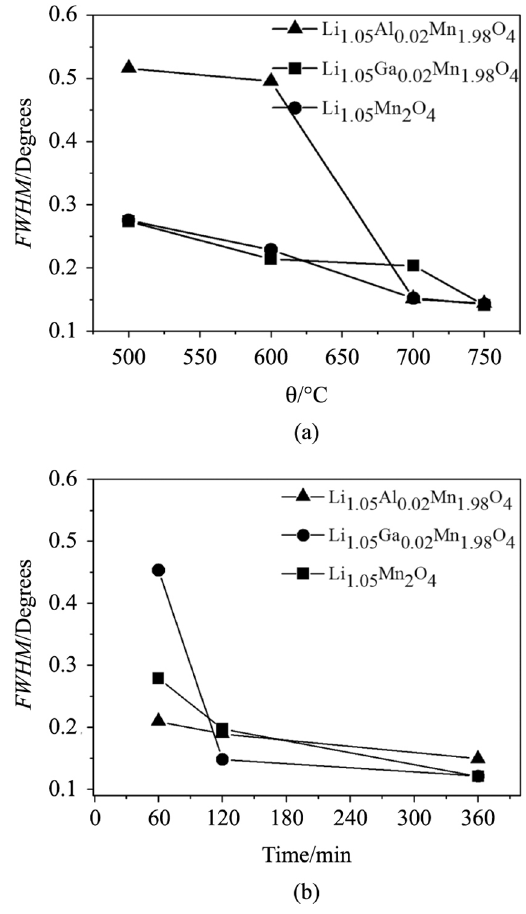
Figure 5. FWHM of the Li Li Al Mn O as a function of the: (a) temperature calcination 1.05 0.02 1.98 4 (for 120 min); (b) time calcination (at 750